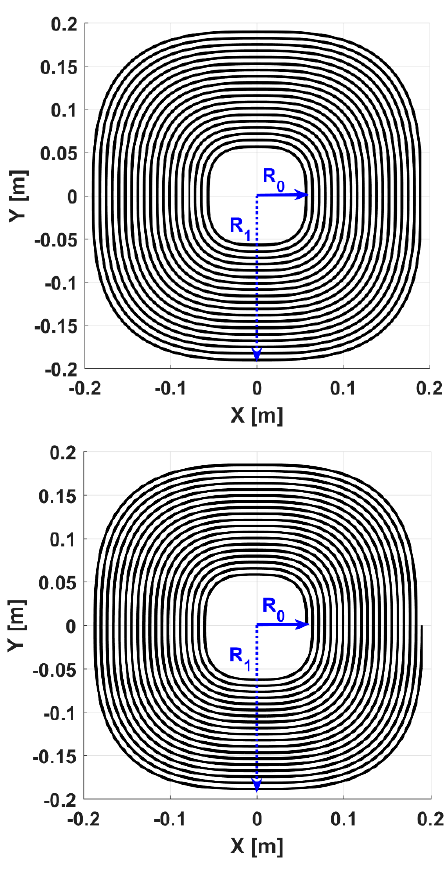
Figure 2. A demonstration of a coil of 19 turns at p = 3 with two configurations: separated ( top ) and connected ( bottom ) turns. The turns are distributed in locations between R 0 and R 1 . The upper figure shows the coil of separated turns, while the bottom figure shows the same coil but with connected